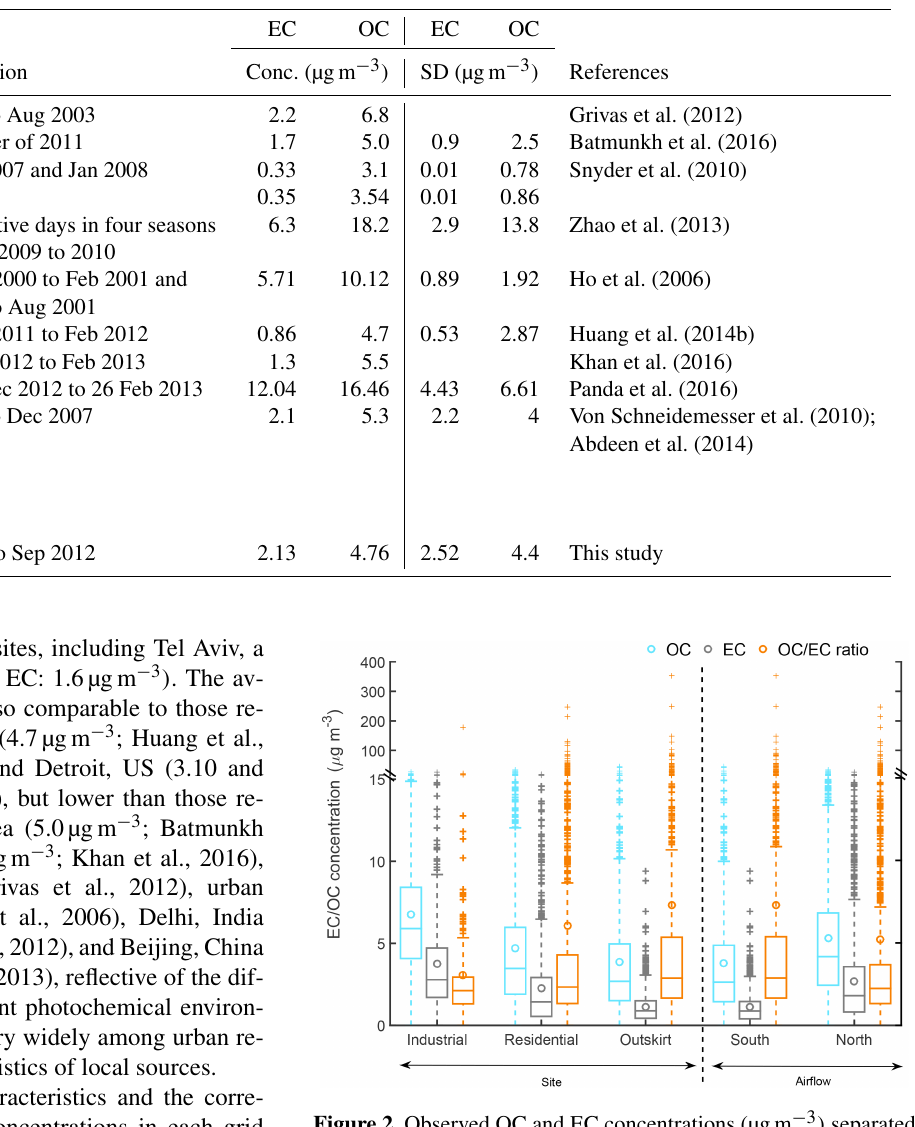
Saudi Arabia and from the south/southwest of the city in April and May, and from the north/northeast from June to September, extending to the west coast of the Persian Gulf. These two dominant wind directions were used to stratify data in Fig. S1b, which show that the average OC concen- tration increased from 3.8 to 5.3 µg m − 3 and EC from 1.1 to 2.7 µg m − 3 when the air mass source region shifted from south/southeast to north/northeast,